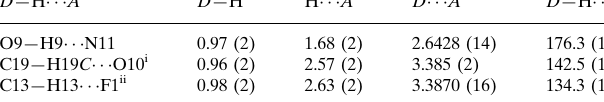
Hydrogen-bond geometry (A˚ , (cid:2) ). D —H (cid:1)(cid:1)(cid:1)